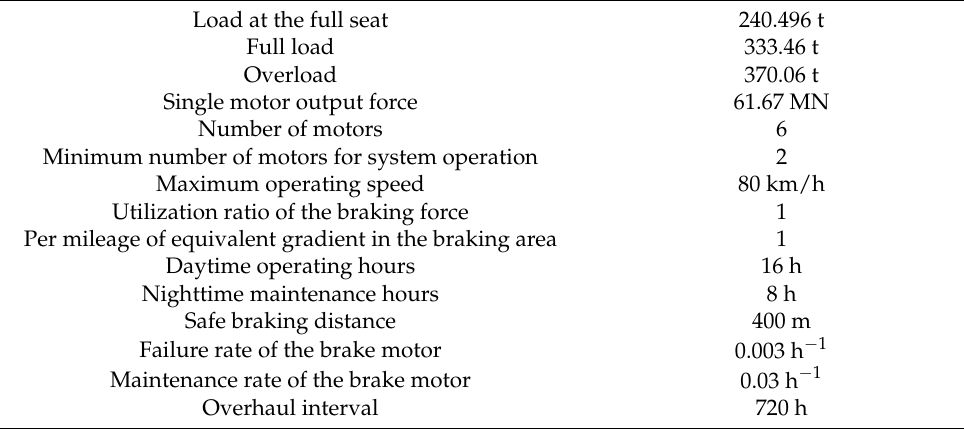
Table 1. Parameters of the